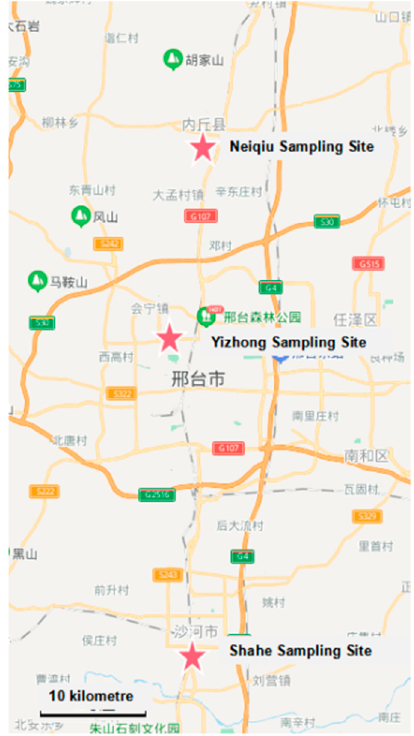
Figure 1. Sampling sites’